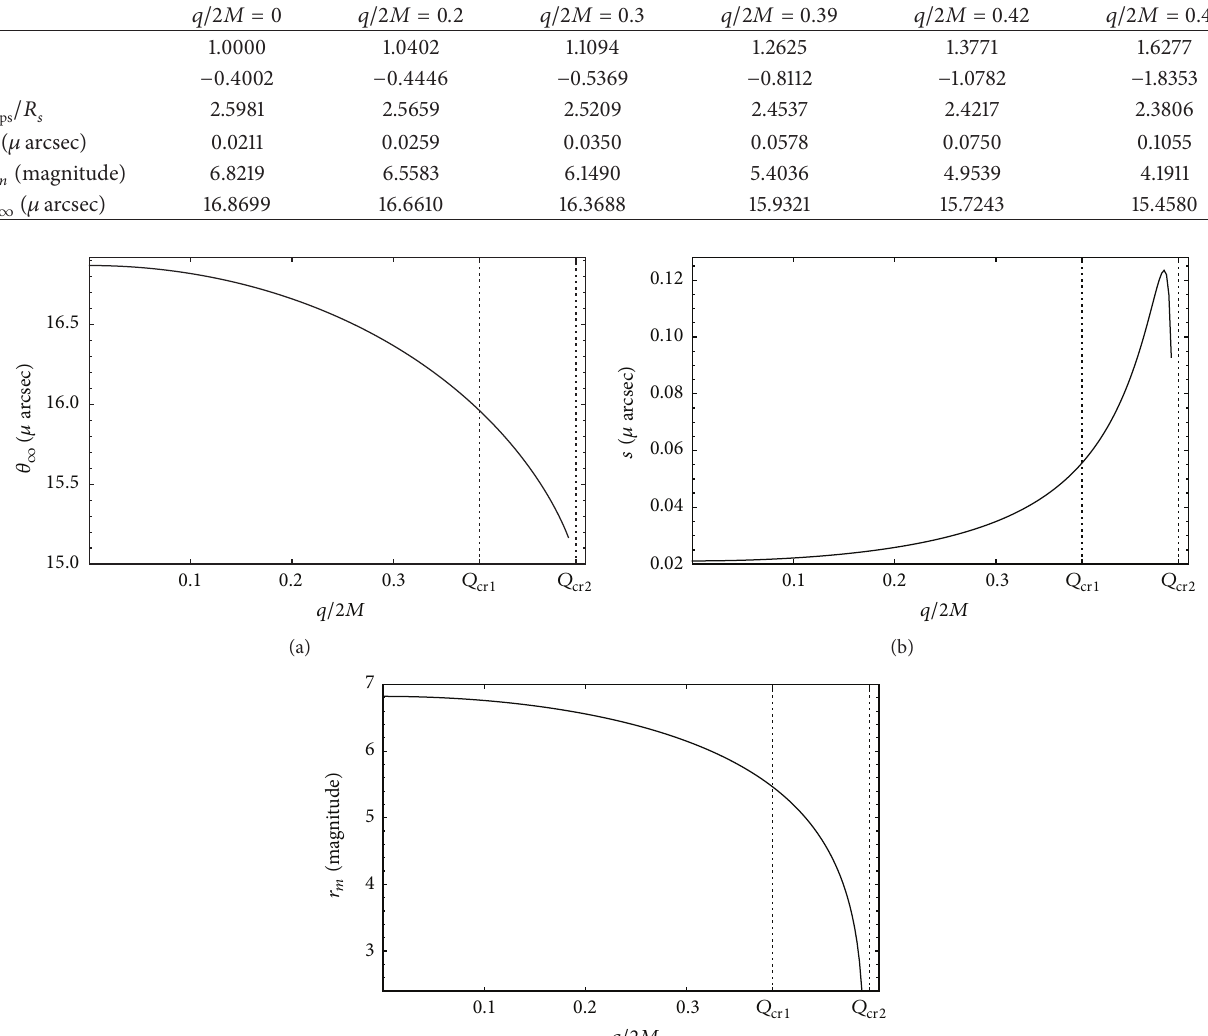
Table 1: Numerical estimation for main observables and the strong field limit coefficients for a Schwarzschild black hole, a nonsingular black hole, and a weakly nonsingular spacetime, which is supposed to describe the object at the center of our galaxy; 𝑟 𝑚 = 2.5 log ̃𝑟 .